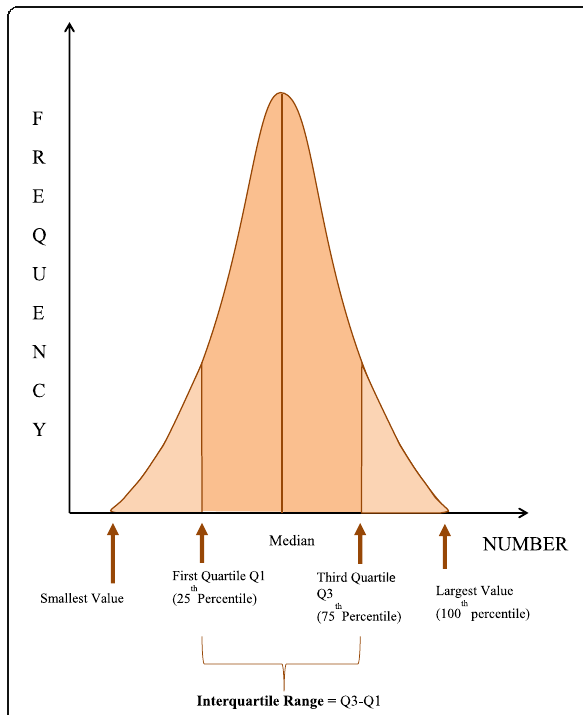
Fig. 2 Relationship of quartiles and inter-quartile range. Legends: Q 1 , first quartile; Q 3 , third quartile; IQR , inter-quartile range